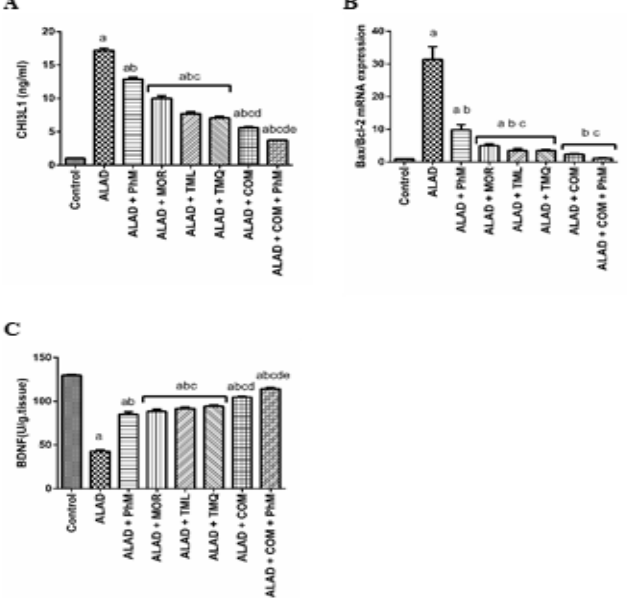
Figure 5. The effect of phytochemicals combination, MOR, TML, and TMQ, with PhM on CHI3L1, BDNF, and apoptosis in AD. ( A ) CHI3L1 levels, ( B ) Bax/Bcl-2 ratio, and ( C ) BDNF levels. The data are presented as means ± SD ( n = 7). Significance (a): relative to the control group. Significance (b): relative to the ALAD group. Significance (c): relative to ALAD + PhM group. Significance (d): rela- tive to either ALAD + MOR, ALAD + TML, or ALAD + TMQ group. Significance (e): relative to ALAD + COM group Significance: p < 0.05. The data of the effect of MOR, TML and TMQ on the control are not shown as they were not significant.